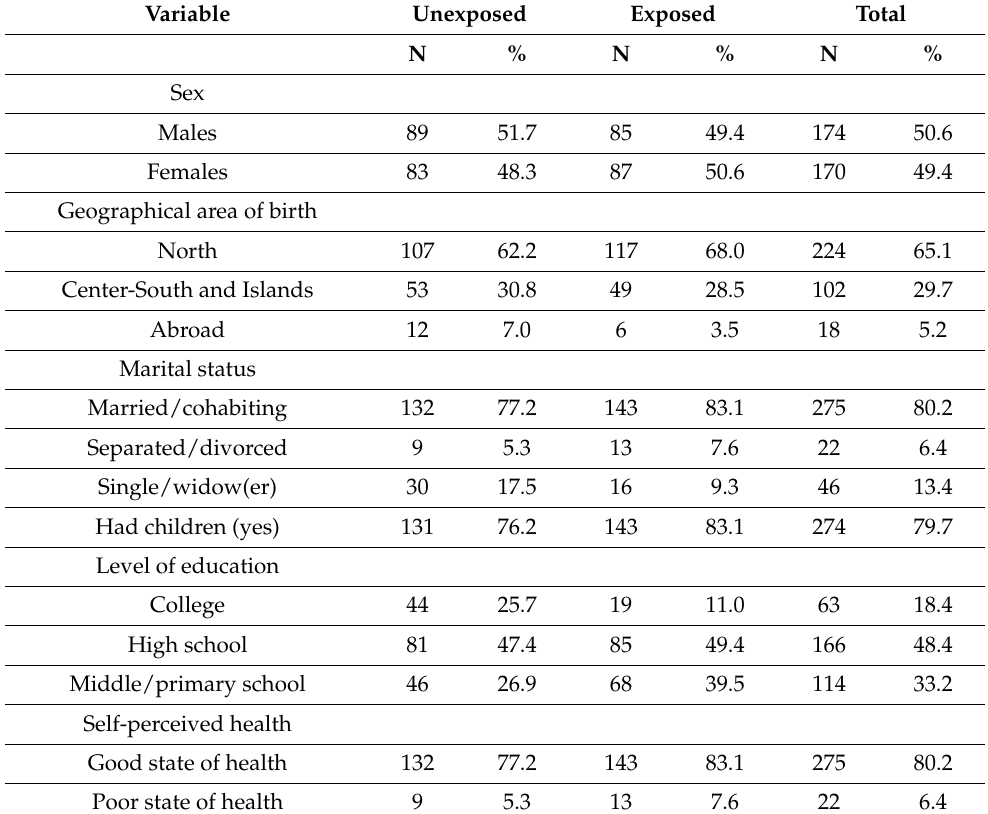
Table 1. Sociodemographic characteristics at T2 (N =